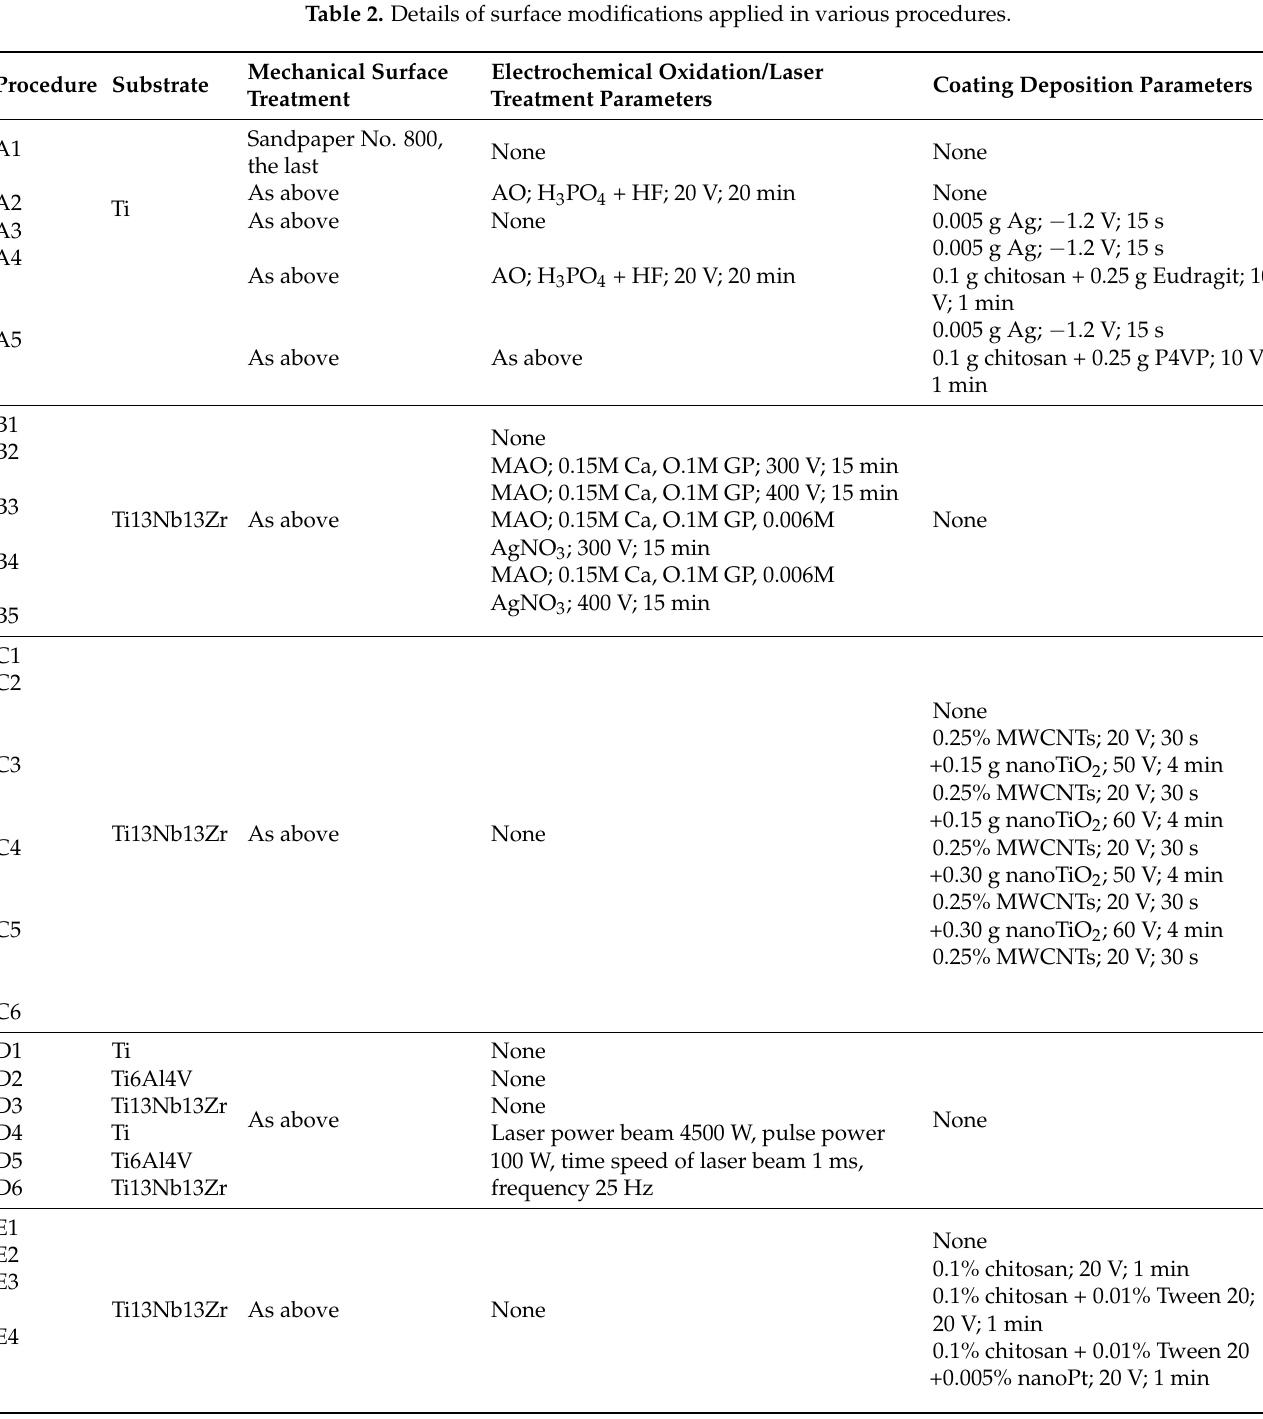
Table 2. Details of surface modifications applied in various